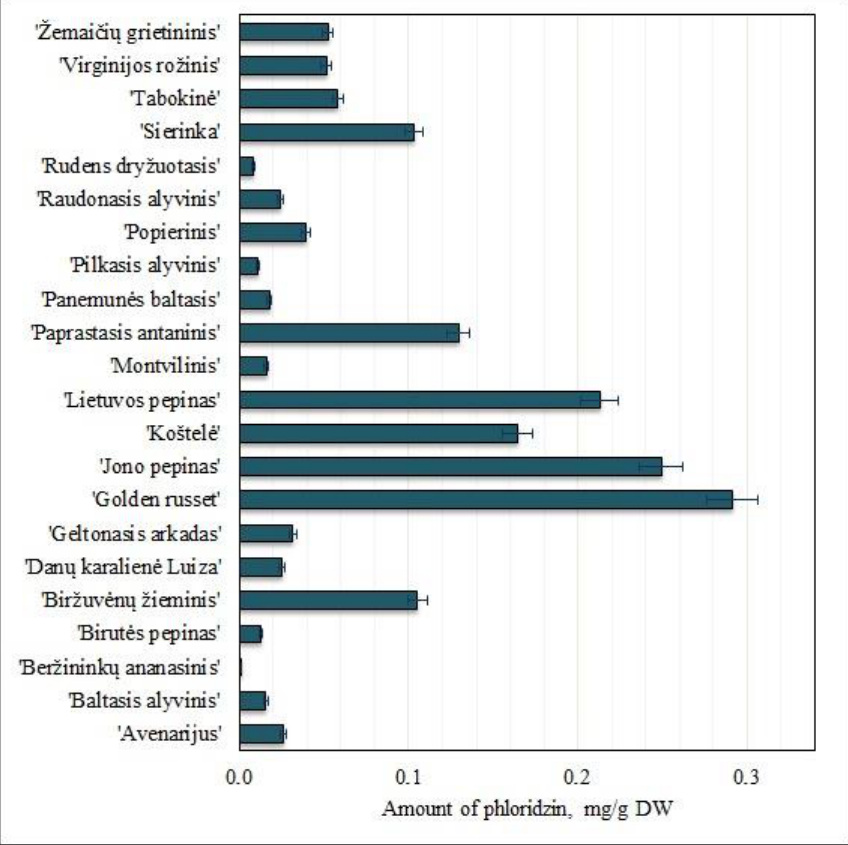
Figure 5 Figure 5. Variability of the amount of phloridzin in fruit samples of heirloom apple